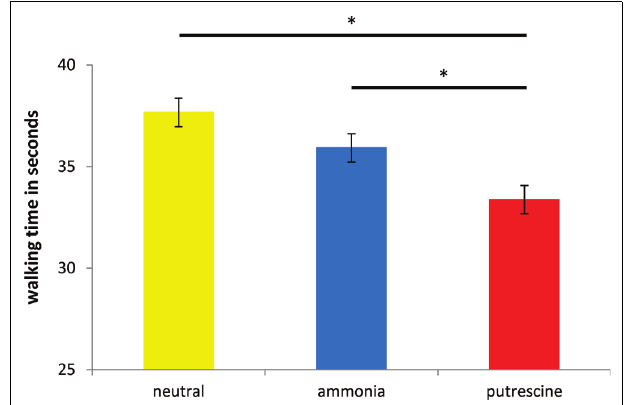
FIGURE 2 | The number of seconds it took participants to walk 60 m after exposure to the scent prime (Experiment 3). Asterisks denote that two groups differ at * p <